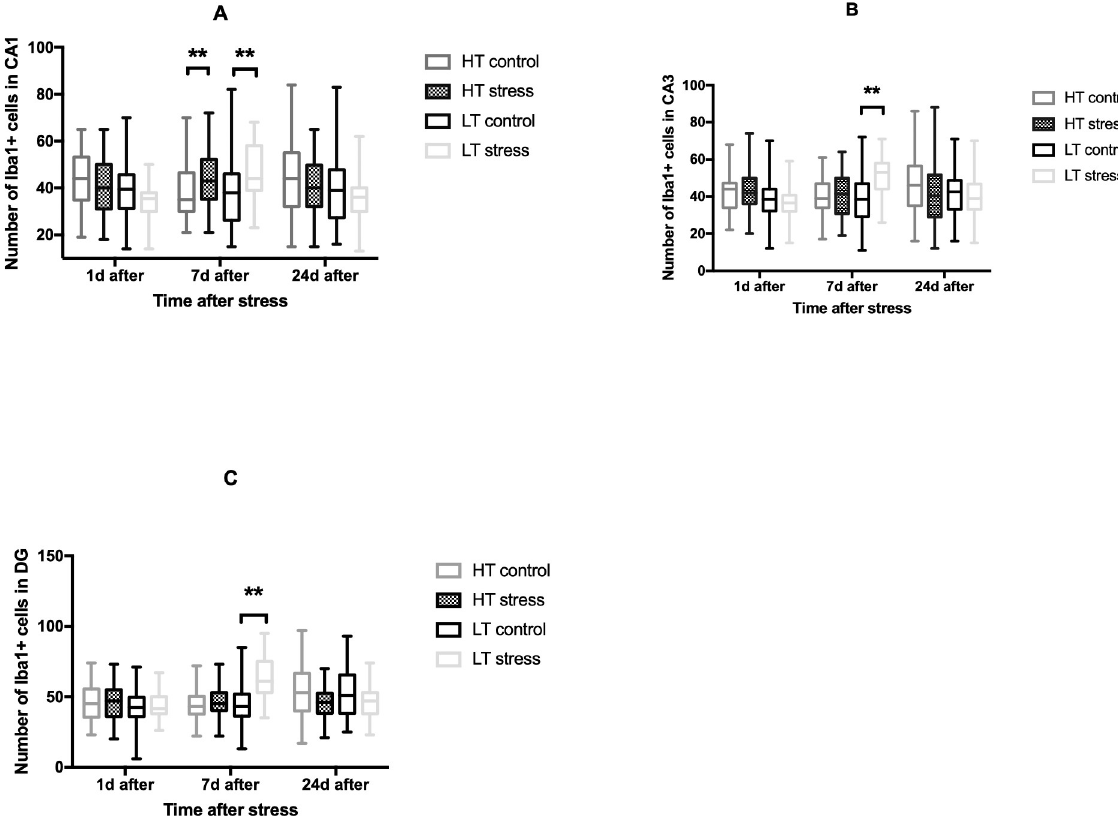
Fig 8. Effect of long-term stress on the number of microglial cells in the hippocampus in HT and LT rats. (A) The number of Iba1+ cells in the CA1 area of the hippocampus, (B)–in CA3 area and (C)–in the dentate gyrus (DG); n = 5–12 per group; bars represent medians and interquartile range; �� p � 0,01 Mann-Whitney U